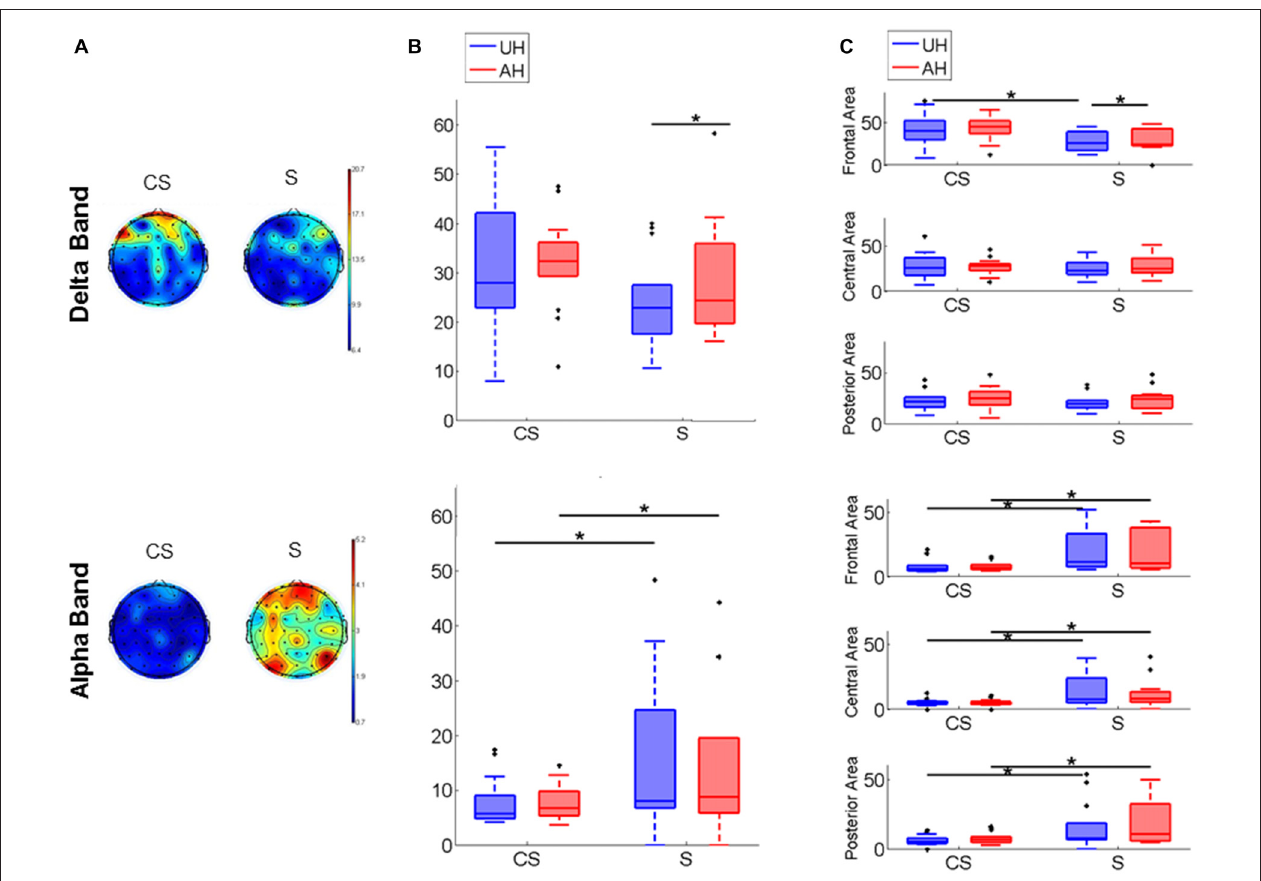
FIGURE 2 | Power spectrum. (A) Power spectrum density (PSD) maps of Delta and Alpha EEG frequency band. Figure shows the Cortico-subcortical stroke patients (CS) scalp distribution on the left and the Subcortical stroke patients (S) scalp distribution on the right. To represent the average map of each group all stroke lesions were considered as affecting the right hemisphere. (B) Power spectral density box-plot of Delta and Alpha bands, Median and Interquartile Range (IQR) of power of unaffected hemisphere (UH) and affected hemisphere (AH) for Cortico-subcortical lesion (CS) and Subcortical lesion (S). (C) PSD box-plot of Delta and Alpha EEG frequency band, Median and IQR of power of Frontal Area, Central Area and Posterior Area for Cortico-subcortical lesion (CS) and Subcortical lesion (S). ∗ p < 0.05.